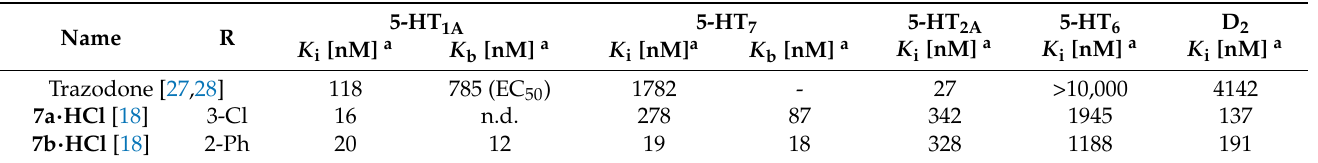
Table 2. Binding and functional data of synthesized compounds 7a · HCl , 7b · HCl and reference trazodone for the selected serotonin and dopamine receptors.